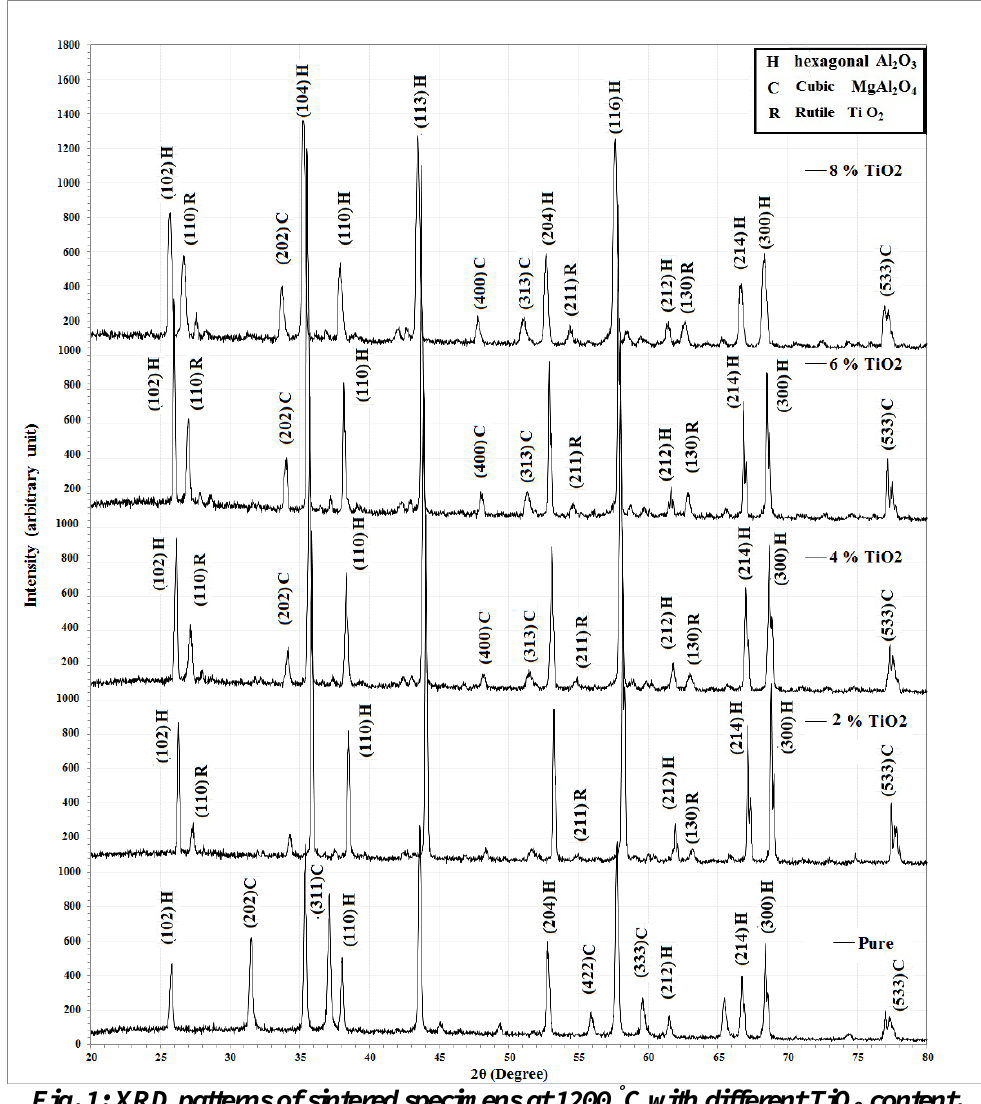
content. 2 O ) the addition oxide (TiO ) in 2 4 2